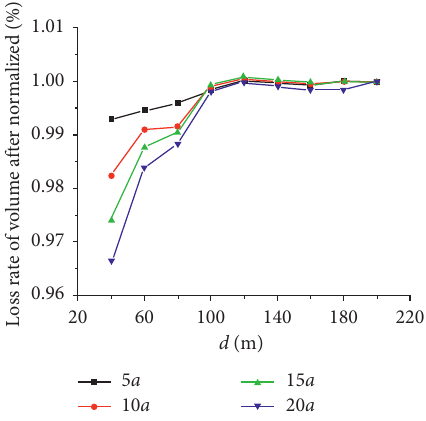
Figure 14: The volume loss rate of the double-cavern horizontal salt rock underground storage varying with the width of the